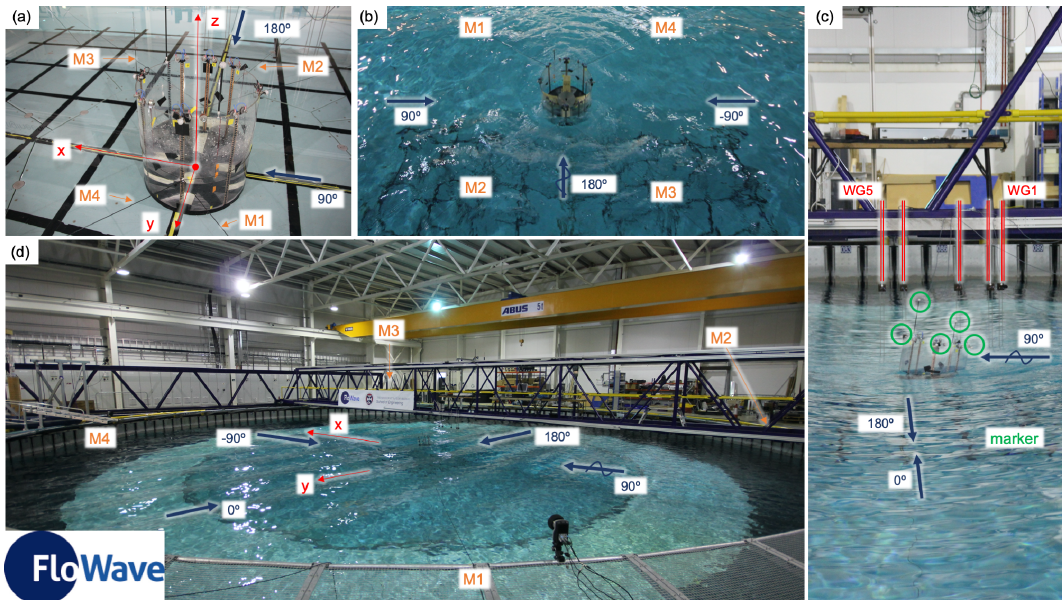
Figure 1. Experimental set-up in the tank on the raised tank floor ( a ) including the global coordinate system and the labelled mooring lines—( b ) solid ballast case under waves coming from 180 ◦ —( c ) side view of the experiments including the wave gauge (WG) array in the back—( d ) overview of the full experimental setting in the tank.